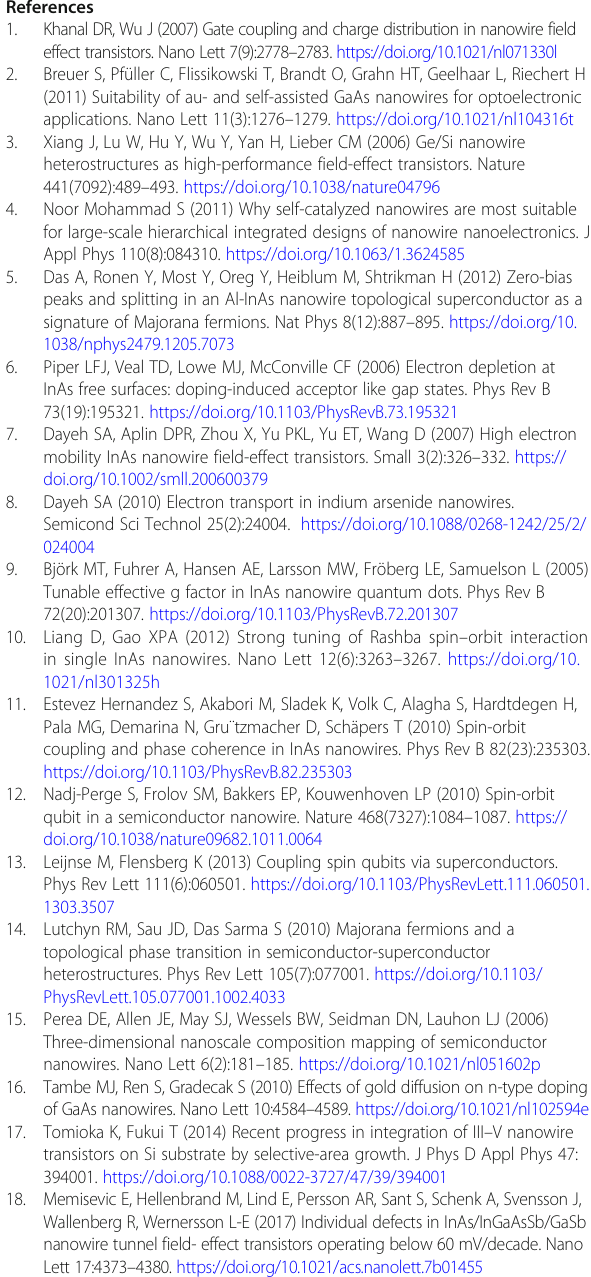
Additional file 1: Figure S1. Schematic illustration of the NW device processing: (a) resist coating, (b) e-beam writing, (c) development, (d) metallization, (e) lift-off process, and (f) the resulting contacted nanowire. The inset in f) shows a SEM topview of a metal contacted InAs NW. Figure S2. SEM side images of the doped and undoped InAs nanowires. a) growth series A and b) growth series B. The GaTe-cell temperature is indicated for each image at the top left. (DOCX 1610